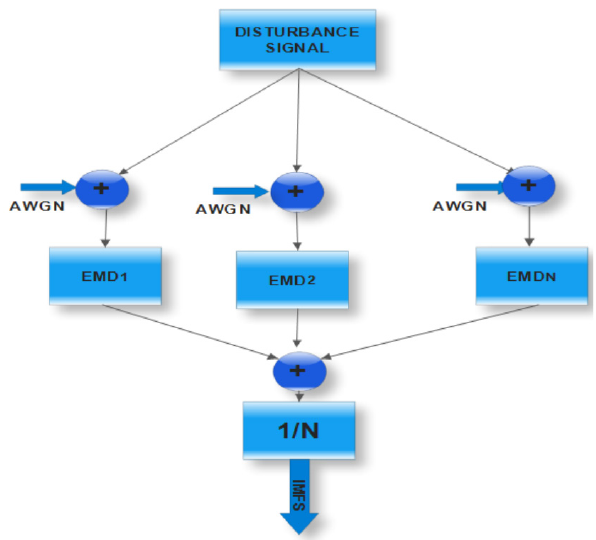
Fig. 2. The representation of the EEMD